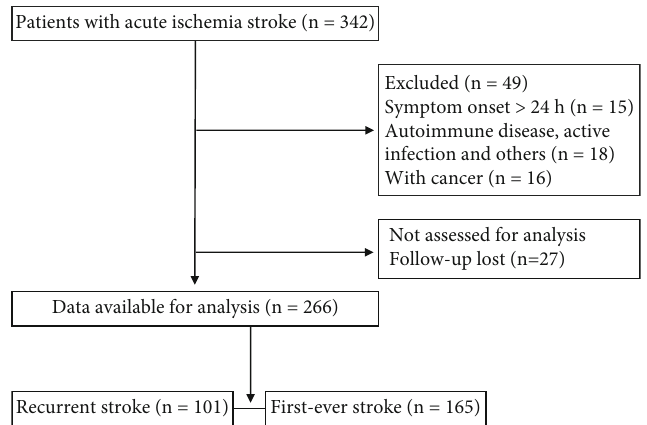
Figure 1: Study fl owchart for participant